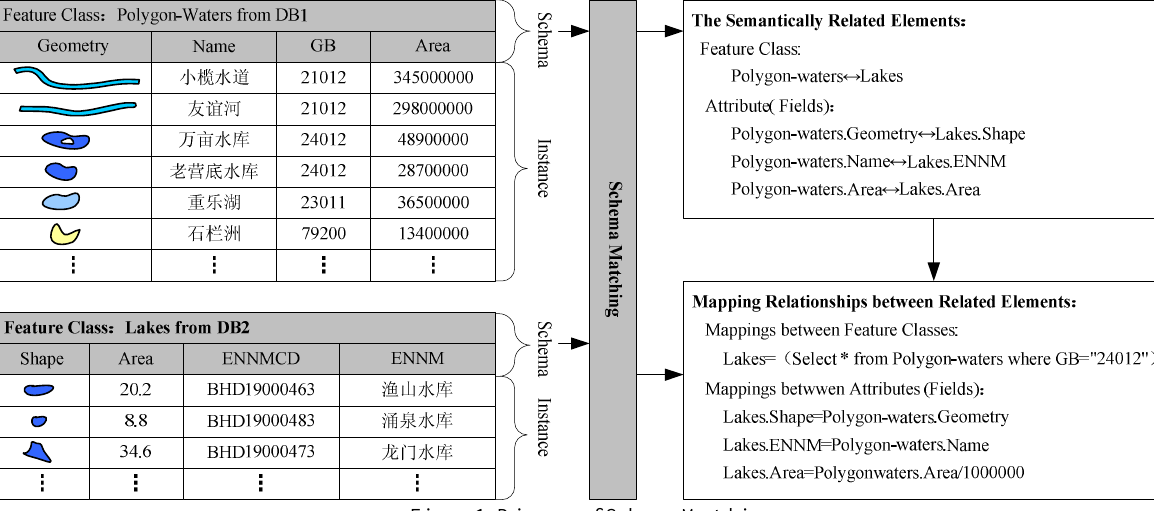
Figure 1. Diagram of Schema